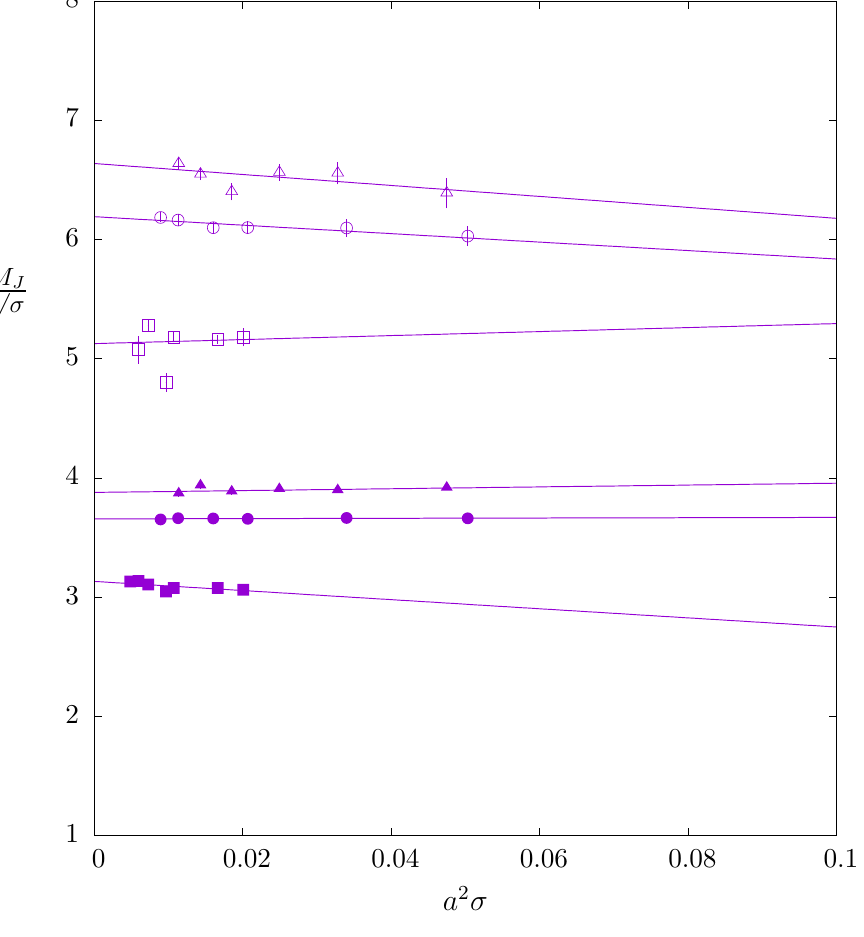
Figure 24 . Lightest 0 + glueball in SO(3) ( (cid:4) ), SO(6) ( (cid:15) ), SO(12) ( N ), and lightest 2 + glueball in SO(3) ( (cid:3) ), SO(6) ( (cid:14) ), SO(12) ( M ), all in units of the string tension and plotted versus the string tension, with linear extrapolations to the continuum